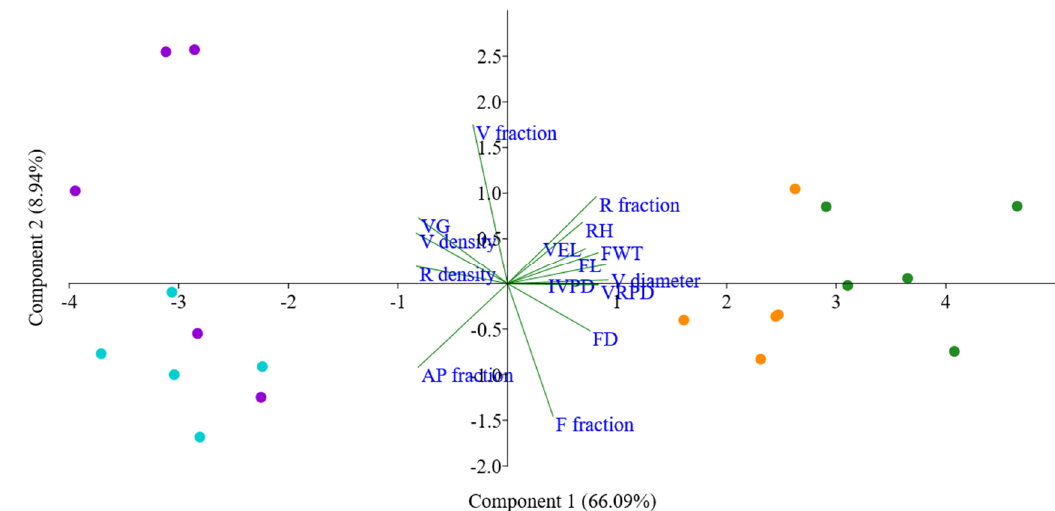
Figure 5. Main component analysis of Enterolobium contortisiliquum 9-year-old trees and 2-year-old saplings. Legends: ● TE = trees in eutrophic soil; ● TO = trees in oligotrophic soil; ● SE = saplings in eutrophic soil; ● SO = saplings in oligotrophic soil; Vdensity = vessel density (n/mm 2 ); VG = vessels grouping; VD = vessel diameter ( µ m); VEL = vessel element length ( µ m); IVPD = intervessel pit diameter ( µ m); VRPD = vessel-ray pit diameter ( µ m); FL = fiber length ( µ m); FD = fiber diameter ( µ m); FWT = fiber wall thickness ( µ m); RH = rays height ( µ m); Rmm 2 = rays density (n/mm 2 ); Vfraction= fraction of vessels; Ffraction = fraction of fibers; APfraction = fraction of axial parenchyma; Rfraction = fraction of rays.